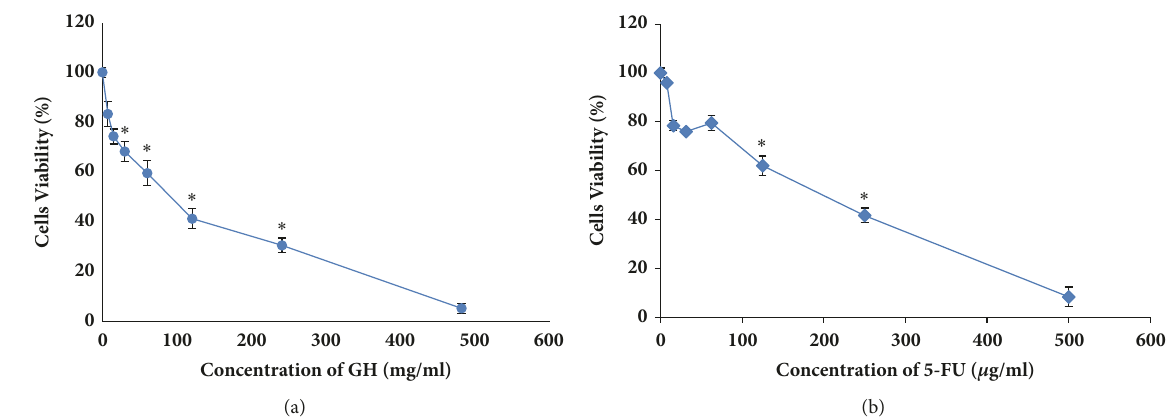
Figure 3: Cytotoxicity of GH and 5-FU against normal colon cells (ATCC (cid:3) CRL-1459) after 72 h of treatment. The CD 50 of GH was 89.8 mg/ml (a) and the CD 50 of 5-FU was 203.1 𝜇 g/ml (b). Each point represents the mean of the results of three independent experiments. Error bars represent means ± S.E.M. of the three independent experiments. ∗ Statistical significance (P < 0.05) between control cells and treatment groups.